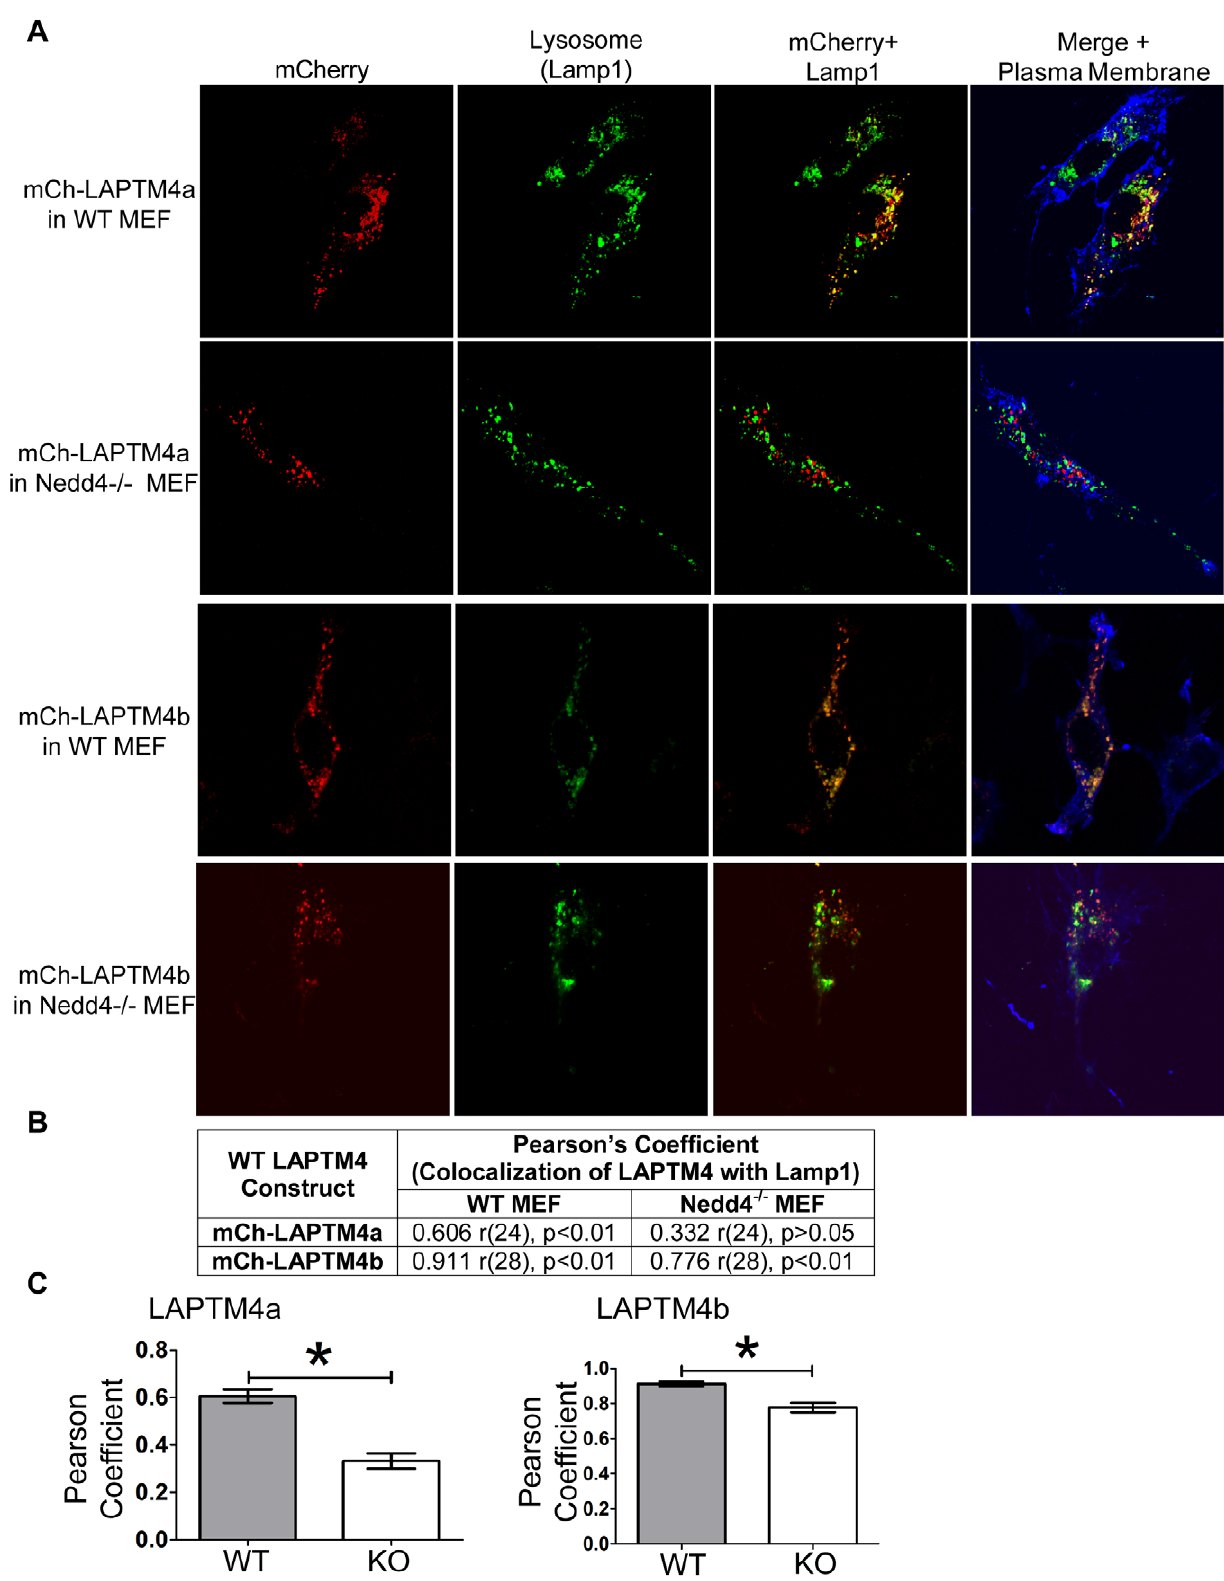
Figure 6. Nedd4 facilitates lysosomal sorting of LAPTM4a and LAPTM4b. (A) WT or Nedd4 2 / 2 MEF cells were transfected with (wildtype) mCh-LAPTM4a or mCh-LAPTM4b (red). 24 hrs post transfection the plasma membranes was stained (ConA, blue), cells were fixed and incubated with anti-Lamp1 antibodies (green). Cells were imaged by confocal microscopy and subcellular localization was assessed using Volocity 5.4.1. (B) LAPTM4 colocalization with the lysosomal marker Lamp1 is expressed in terms of the Pearson’s correlation coefficient. Degrees of freedom are noted as (r),